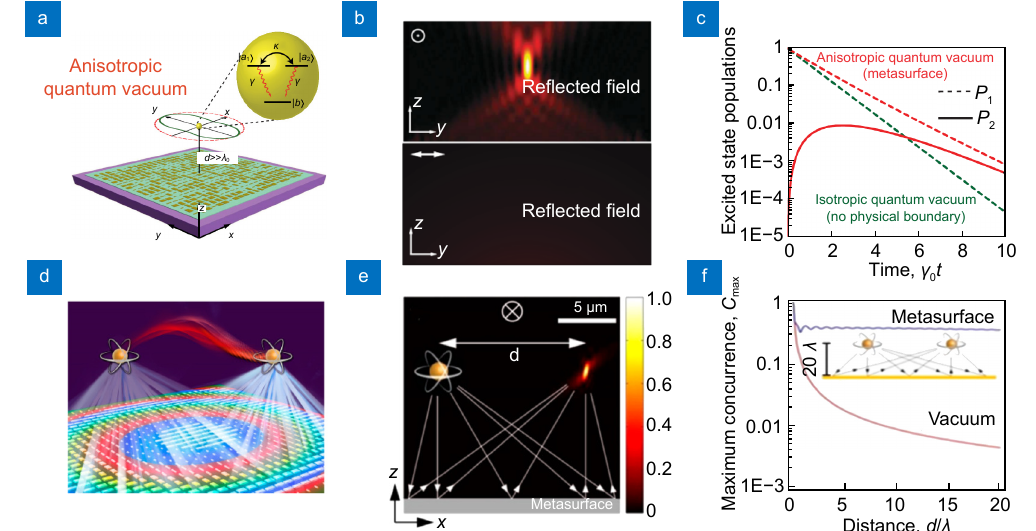
Fig. 4 | Quantum vacuum engineering based on metasurfaces. ( a ) Based on metasurfaces, the quantum vacuum symmetry of quantum emit- ter is broken, so that quantum interference between different energy levels of multi-level quantum emitter occurs. ( b ) The electromagnetic field ra- diated by an electric dipole in the x direction above metasurface can be focused back to the source point along the original path with the maxim- um efficiency being 81% and the electromagnetic field radiated by an electric dipole in the y direction has no such effect. ( c ) When there is no metasurface, the energy level | a 1 decayed exponentially and the energy level | a 2 occupied 0. When the metasurface exists, the decay rate of the energy level | a 1 decreases, and the energy level | a 2 population firstly increases and then decreases. ( d ) Schematic diagram of quantum en- tanglement of two quantum emitters based on metasurface. ( e ) The metasurface enables the electromagnetic field radiated by the source point electric dipole to be oriented to the position of the target electric dipole with highest efficiency 82%. ( f ) The concurrence of two quantum emitters varies with the distance between them, the red solid line corresponds to the vacuum condition, and the blue solid line corresponds to the metas- urface condition. Figure reproduced from: (a-c) ref. 102 , American Physical Society; (d-e) ref. 103 , American Physical